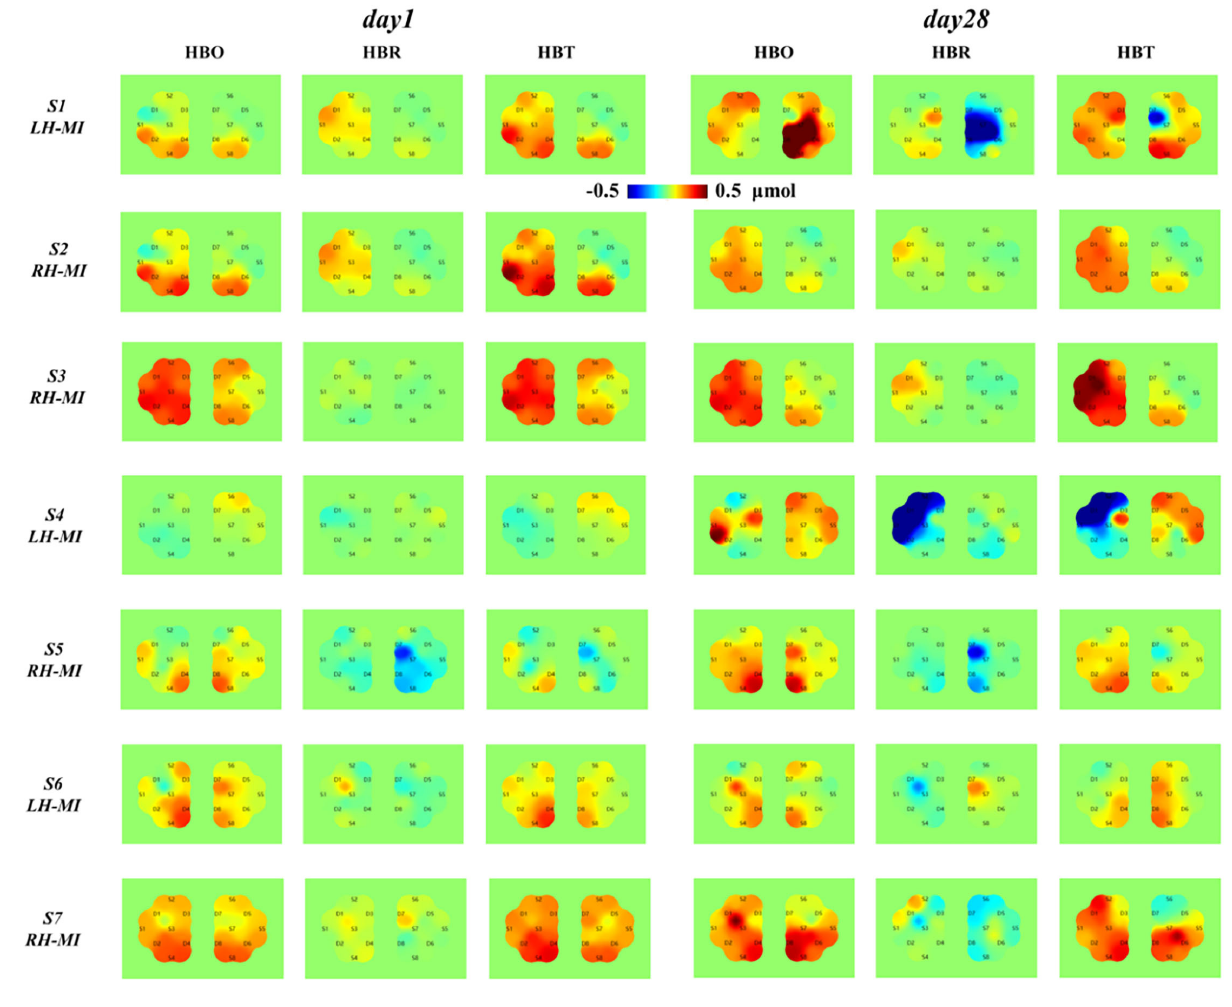
FIGURE 10 | Topological distribution of cerebral blood oxygen concentration in patients with fNIRS before and after long-term exercise